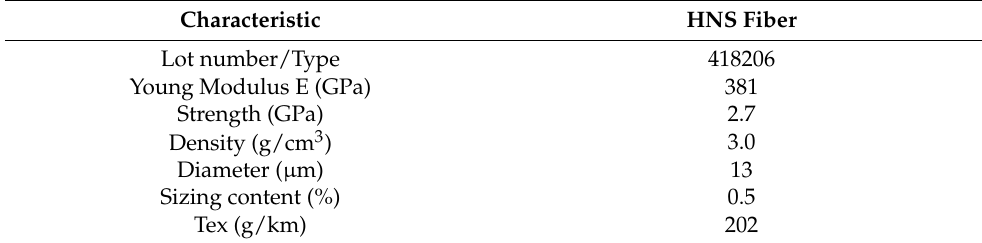
Table 1. Fiber’s main characteristics provided by